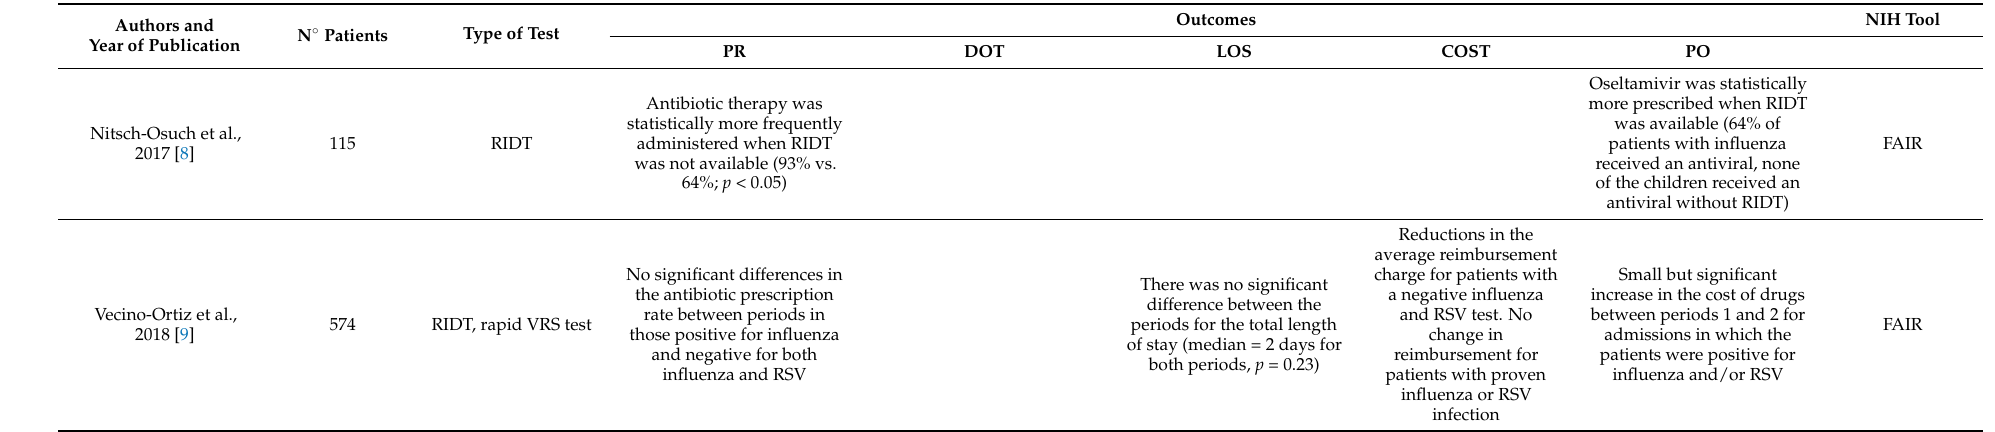
Table 2. Outcomes of the studies included in the